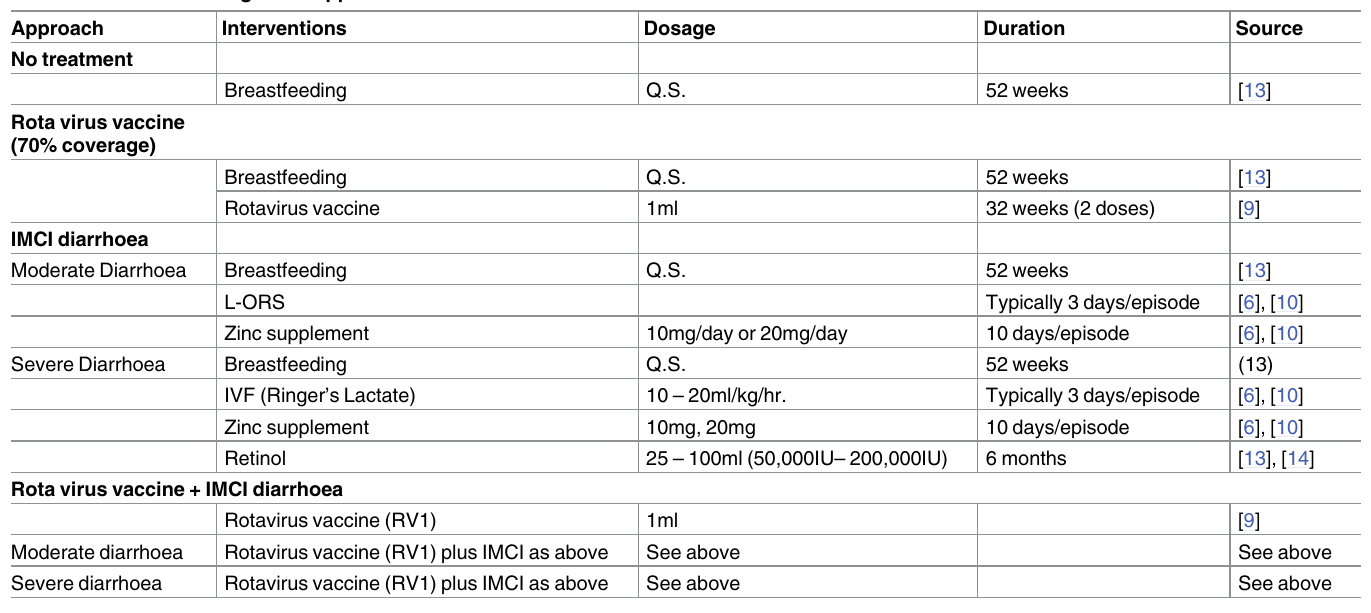
Table 1. Diarrhoea management